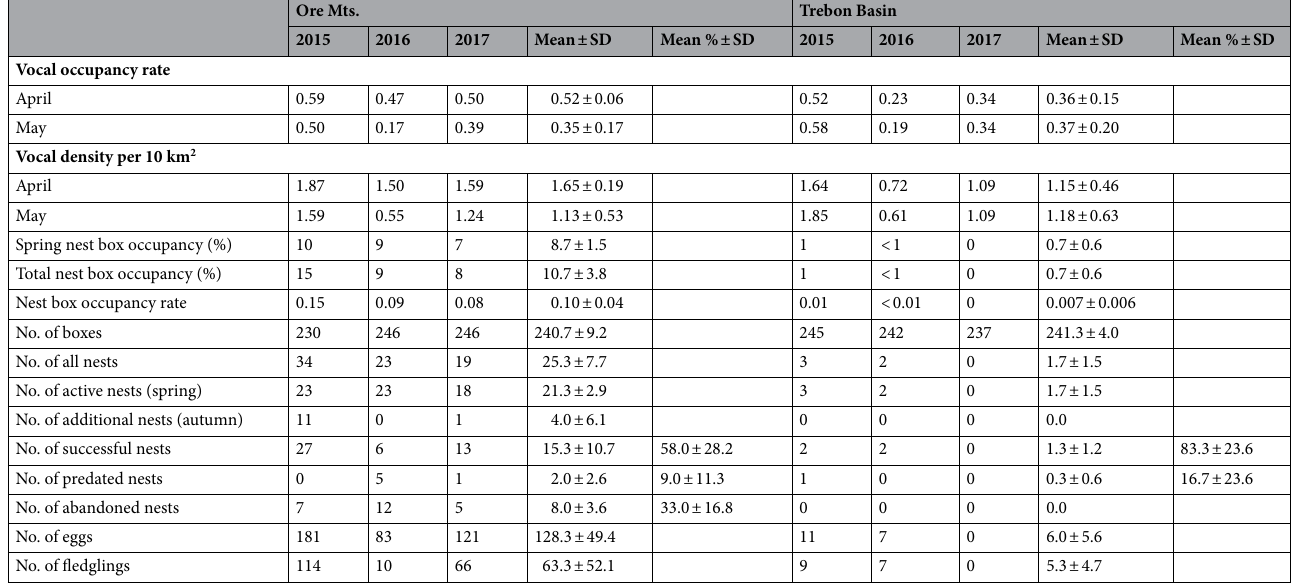
Table 5. Boreal owls nesting in 2015–2017 in the Ore Mts. and Trebon Basin: the vocal occupancy rate, the density of vocalising individuals, the proportion of spring (i.e., only nests during spring inspections) and total (i.e., all nests) nest box occupancy, the number of boxes, all nests, active nests (i.e., during spring nest box inspections), additional nests (i.e., during autumn nest box inspections), successful nests, nests predated by martens, nests abandoned by boreal owl females (including the proportion of all nests), and the total number of eggs and fledglings.